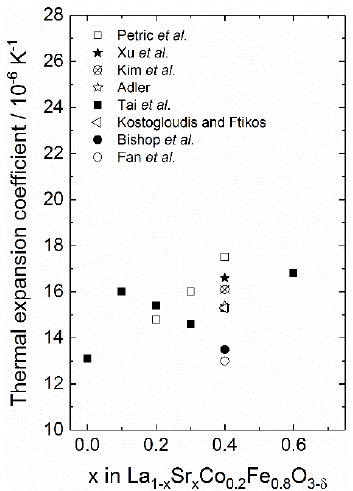
Figure 9. Linear thermal expansion coefficients of La 1−x Sr x Co 0.2 Fe 0.8 O 3−δ (LSCF) as a function of Sr-content, x. All values are summarized in Table 9 along with the references used. Average values have been used for studies where only ranges in the thermal expansion coefficient are provided. Table 9. Linear thermal expansion coefficients of La 1 − x Sr x Co 0.2 Fe 0.8 O 3 − δ (LSCF).